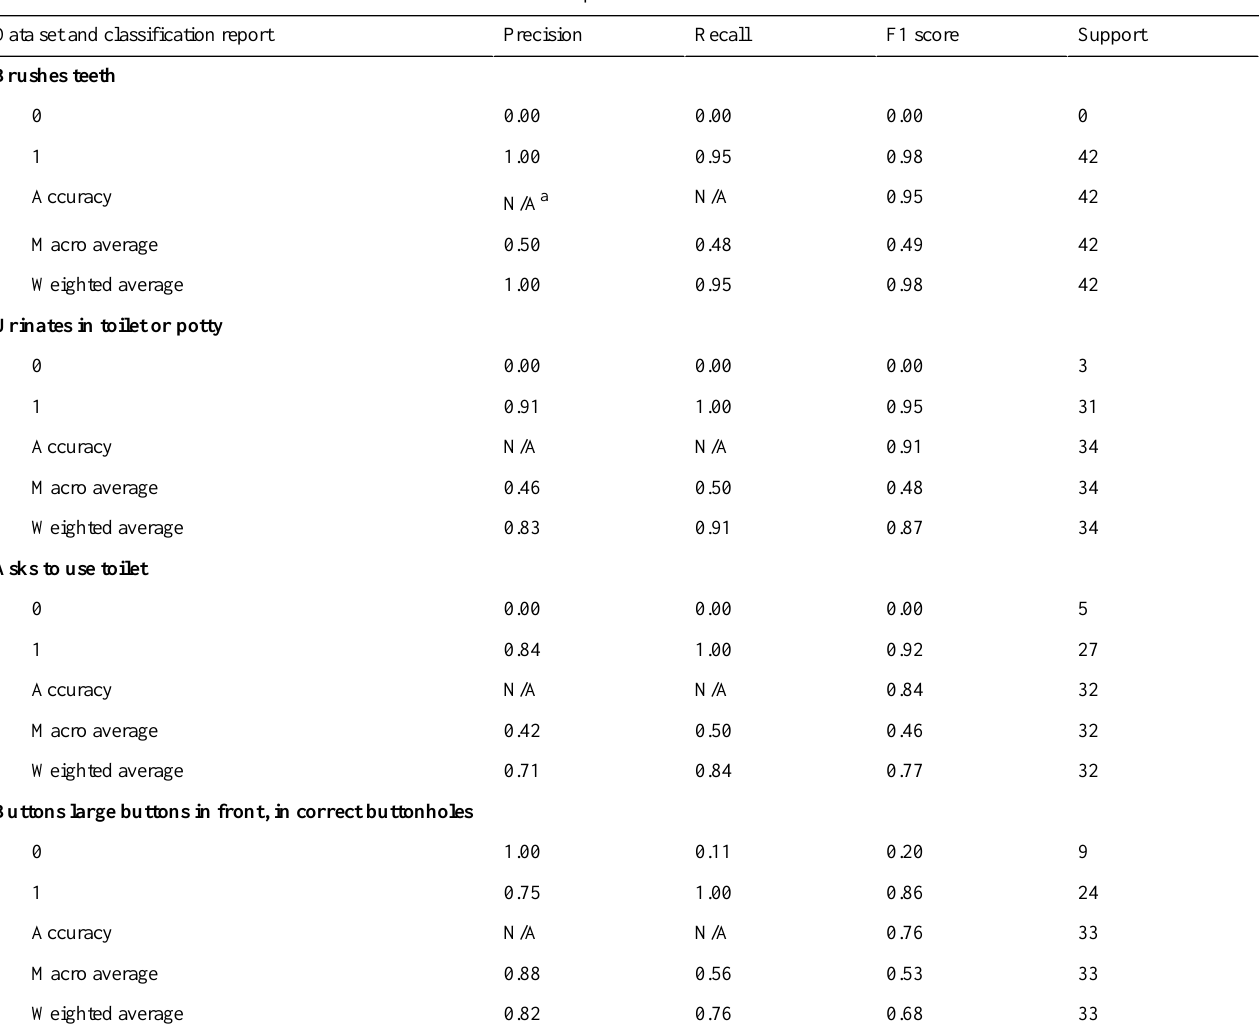
Table 4. The artificial neural network model’s overall classification report for all data sets.